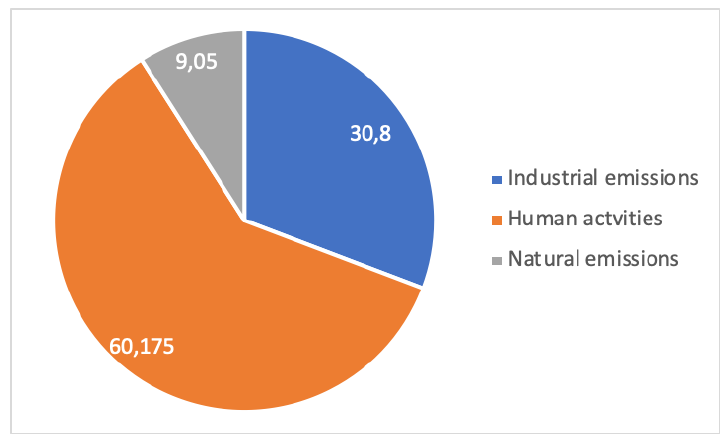
Figure 14. Local pollution in the Vitória metropolitan area: distribution of TSP according to sources of emissions (adapted from [45]).